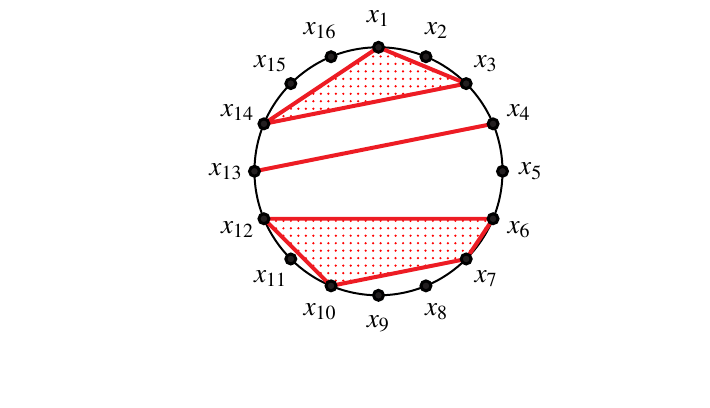
Figure 3: A noncrossing